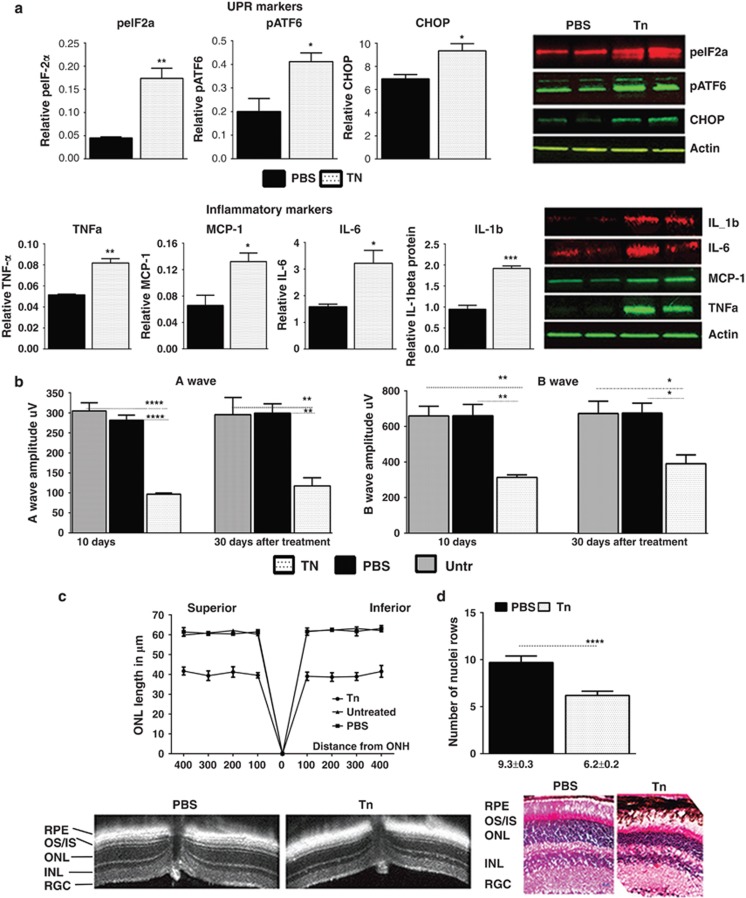
Persistently activated UPR in the wild-type retina induces retinal
degeneration. The distribution of data values is shown in S.E.M. (a)
Western blot analysis of Tn- or PBS-injected retinal protein extracts
(N=4). Upper: a dose of 0.01 mg Tn activated the
UPR in the retina 3 days post treatment. The UPR markers pEIF2a, CHOP and
pATF6 were significantly increased compared with PBS-injected retinas
(P=0.001, P=0.028 and
P=0.020, respectively). Images of western blots are shown on
the side. Bottom panel: activation of the UPR was observed concomitantly
with the induction of inflammatory signaling in Tn-injected wild-type
retinas. The inflammation markers IL-1β, IL-6, MCP-1 and
TNF-α were upregulated 3 days post injection, suggesting
that Tn injection induced not only UPR activation but also led to activation
of an inflammatory response in the retina (P=0.001,
P=0.029, P=0.021 and
P=0.002). The calculation of the Tn-induced microglial
response is shown in Supplementary Figure
S1. (b) Scotopic ERG responses were significantly reduced
in Tn-injected retinas at 10 and 30 days after treatment
(N=6). Although no difference was observed between the
PBS-injected and naive retinas, the a- and b-wave amplitudes were reduced by
>60%, 30 days after Tn treatment (*P<0.05,
**P<0.01, ***P<0.001 and
****P<0.0001). (c) A loss of retinal
integrity in Tn-injected wild-type retinas was measured by SD-OCT
(N=6). A >30% reduction in the ONL thickness
was observed across all of the Tn-injected retina compared with PBS-injected
mice, ****P<0.0001 at all measurement points.
Bottom: SD-OCT images taken from PBS- and Tn-injected retinas. (d)
Histological analysis following H&E staining of Tn-injected
cryostat-sectioned retinas demonstrated a significant loss of photoreceptor
cells. The number of rows of photoreceptor nuclei in the Tn-injected retinas
was 36% lower compared with PBS-injected mice. Bottom: images of the
H&E-stained retinas 30 days after treatment, (P=0.001).
Scale bar indicates 20 μm